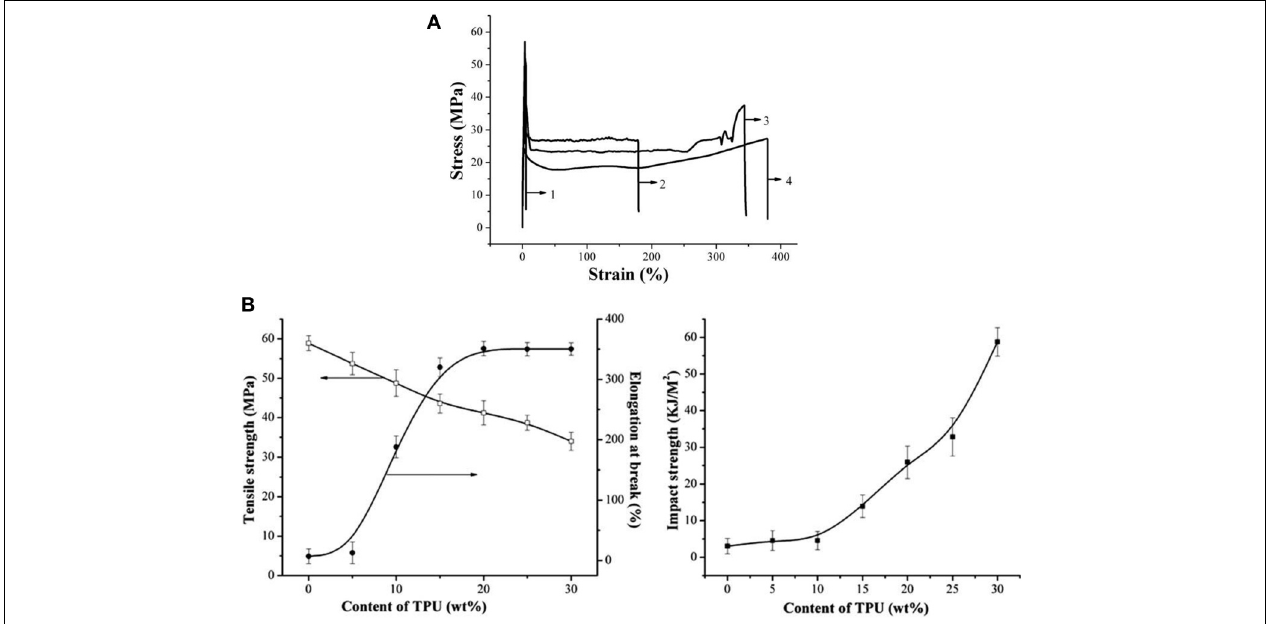
FIGURE 6 | (A) Tensile stress–strain curves of the PLA/TPU blends: (1) PLA/TPU (100/0), (2) PLA/TPU (90/10), (3) PLA/TPU (80/20), and (4) PLA/TPU (70/30). (B) Mechanical properties of the PLA/TPU blends as a function of the TPU content. Copyright (2010) Wiley; used with permission from Feng and Ye (2011).